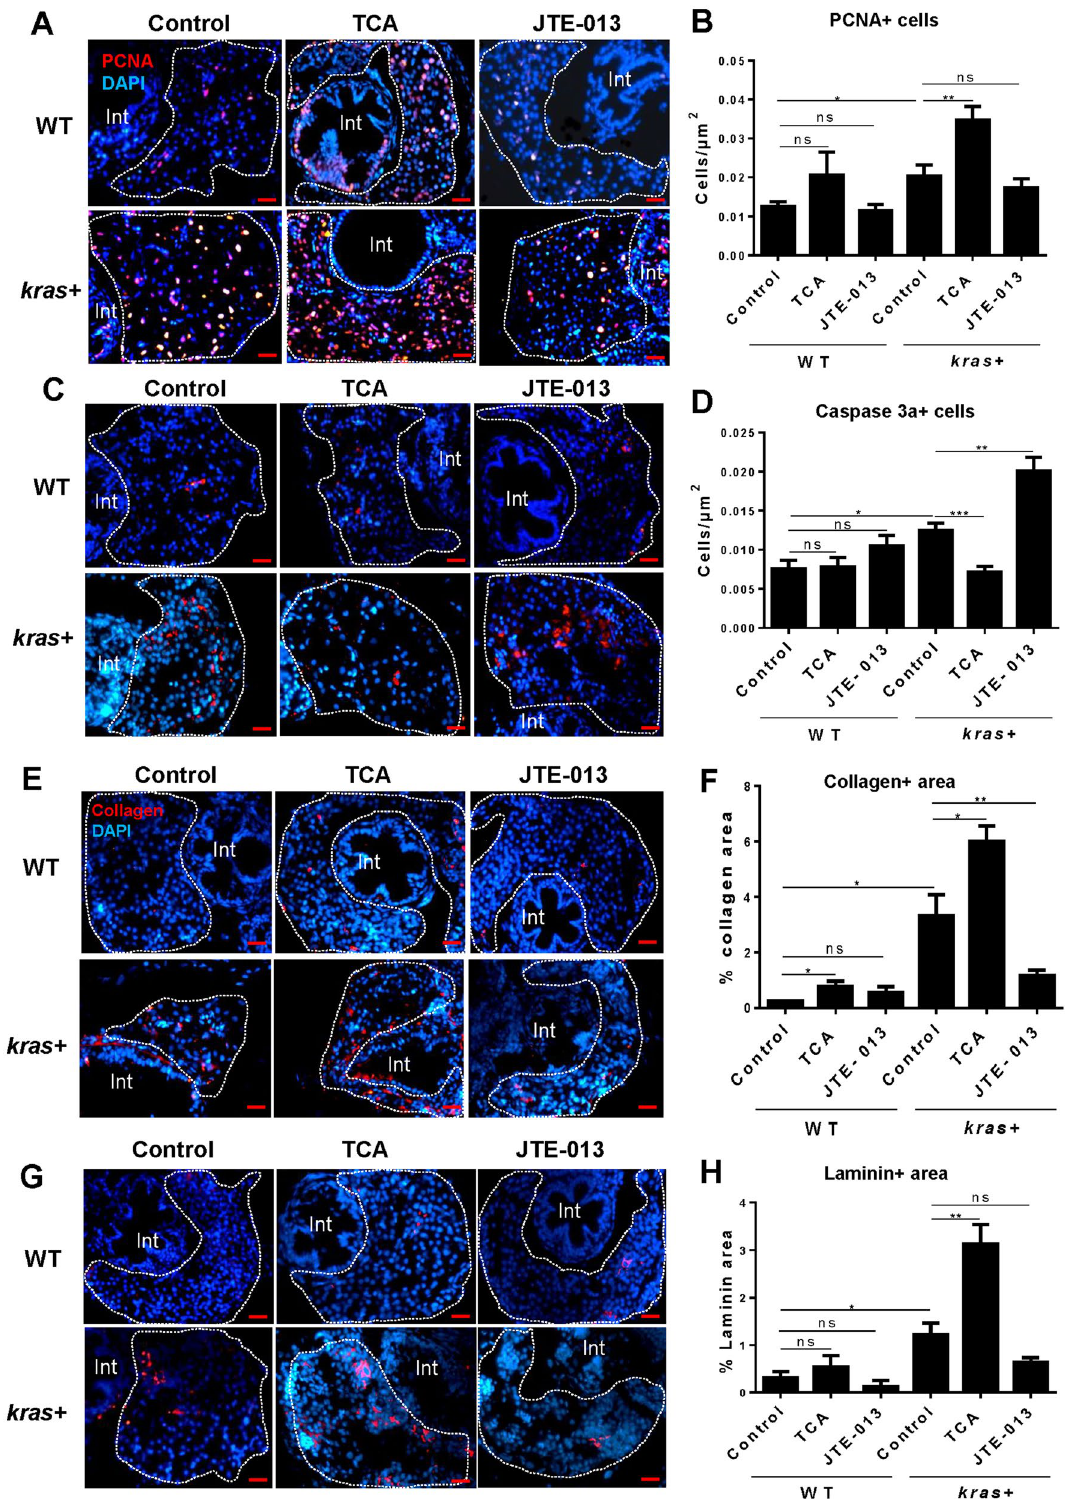
Figure 3. Effect of cholangiocyte activation and inhibition on hepatocyte proliferation, apoptosis and fibrosis. 3-dpf kras + and WT zebrafish larvae were treated with either TCA or JTE-013 along with 20 µg/mL Dox till 8 dpf. Samples were collected for immunohistochemistry. kras + and WT liver sections were incubated with primary antibodies for PCNA, Caspase 3a, Collagen or Laminin and then stained with Alexa Fluor 546 conjugated secondary antibody. All liver sections were counter-stained with DAPI. ( A , C , E , G ) Representative images of staining for PCNA ( A ), Caspase 3a ( C ), Collagen ( E ) and Laminin ( G ) of kras + and WT zebrafish larvae in different groups. ( B , D , F , H ) Quantification of staining signals. For PCNA and Caspase 3a staining, number of stained cells were quantified. For Collagen and Laminin stainings, stained areas were quantified. N = 10 each group. Scale bar: 20 μm. Statistical significance: *P ˂